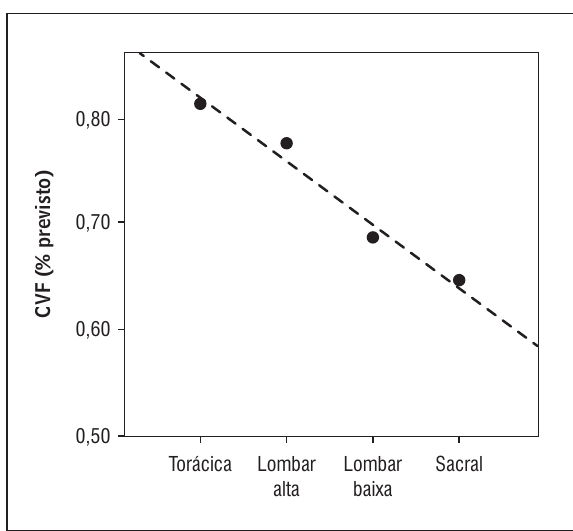
Figura 2 - Relação entre o nível de lesão funcional e ca- pacidade vital forçada das crianças